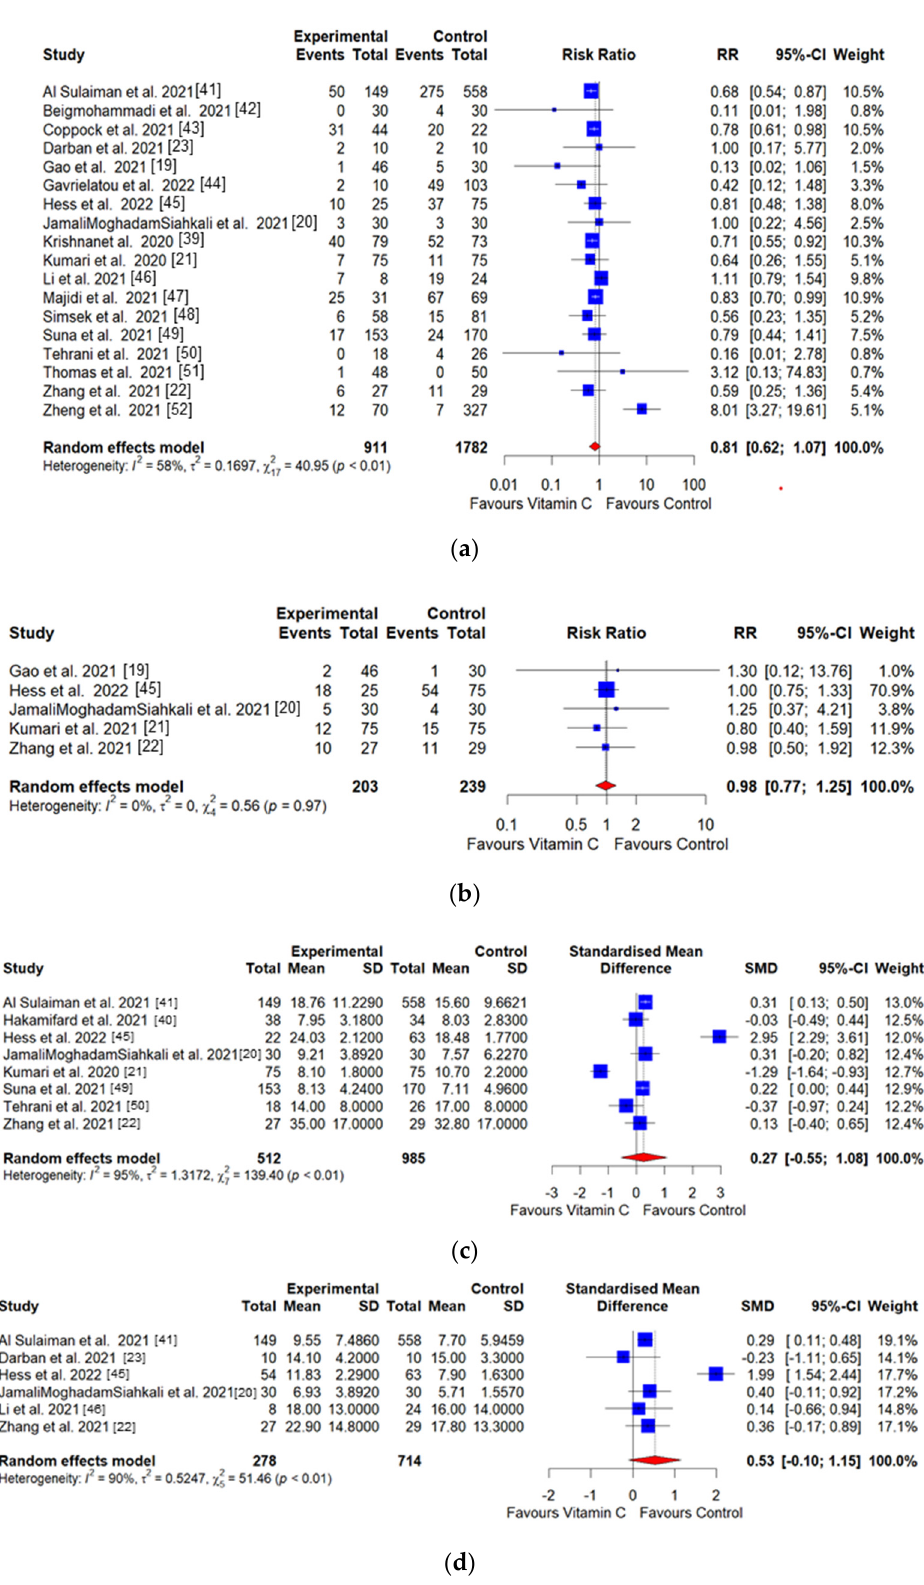
Figure 3. Results of the meta-analysis on the difference in the risk ratio (RR) for ( a ) all-cause mortality, ( b ) ventilation incidence, ( c ) mean difference for hospitalization duration, and ( d ) length of ICU stay between intervention and control groups.